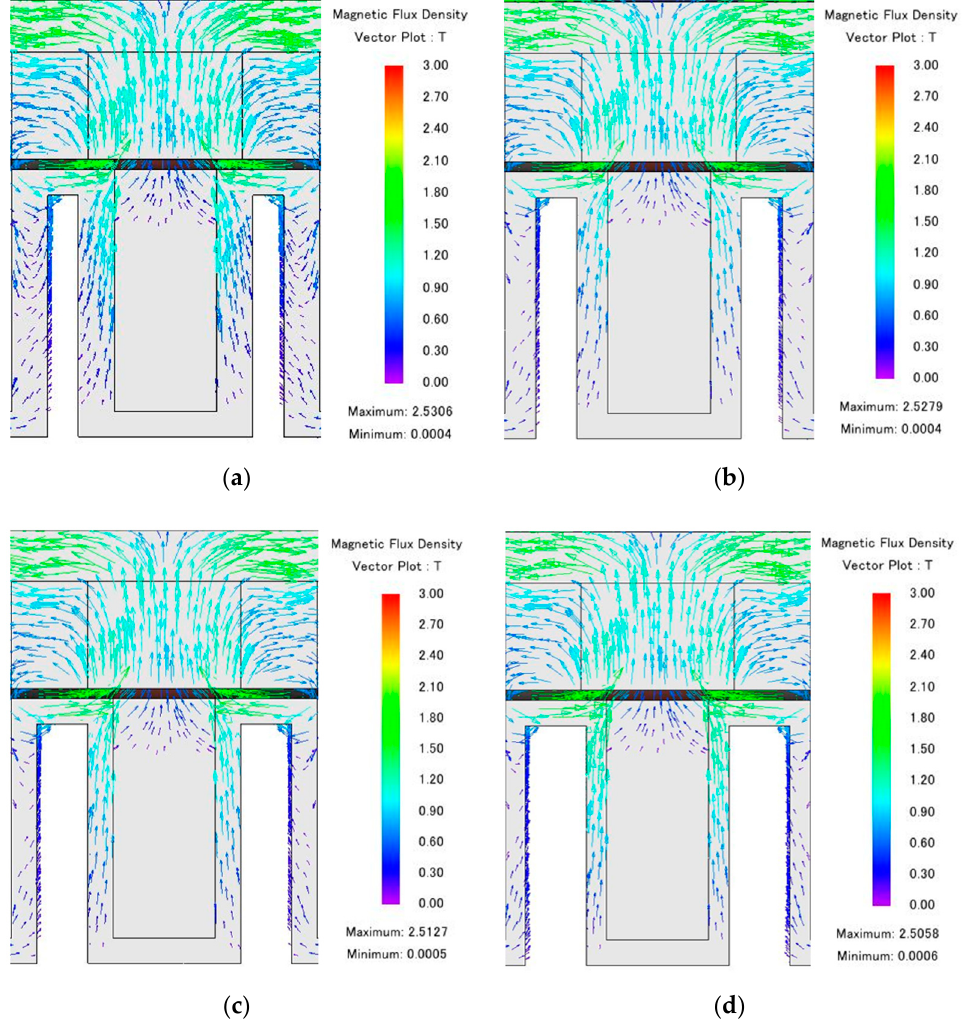
Figure 13. Magnetic flux density for slot spacing of ( a ) 3 mm, ( b ) 4 mm, ( c ) 5 mm, and ( d ) 6 mm.